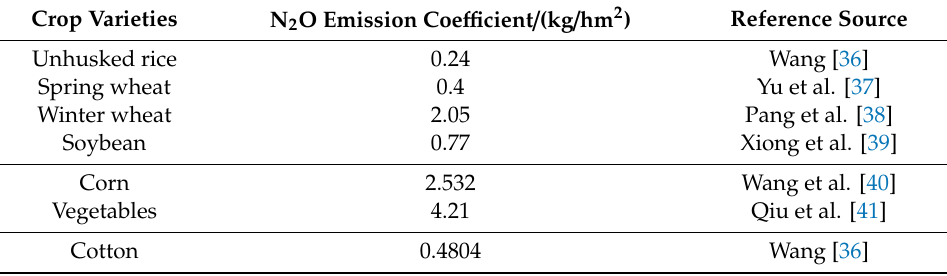
Table 2. Emission coe ffi cient of various crop